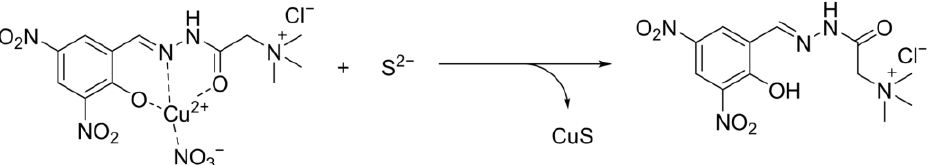
Scheme 3. Proposed detection feature of HDHT – Cu 2+ with S 2− .